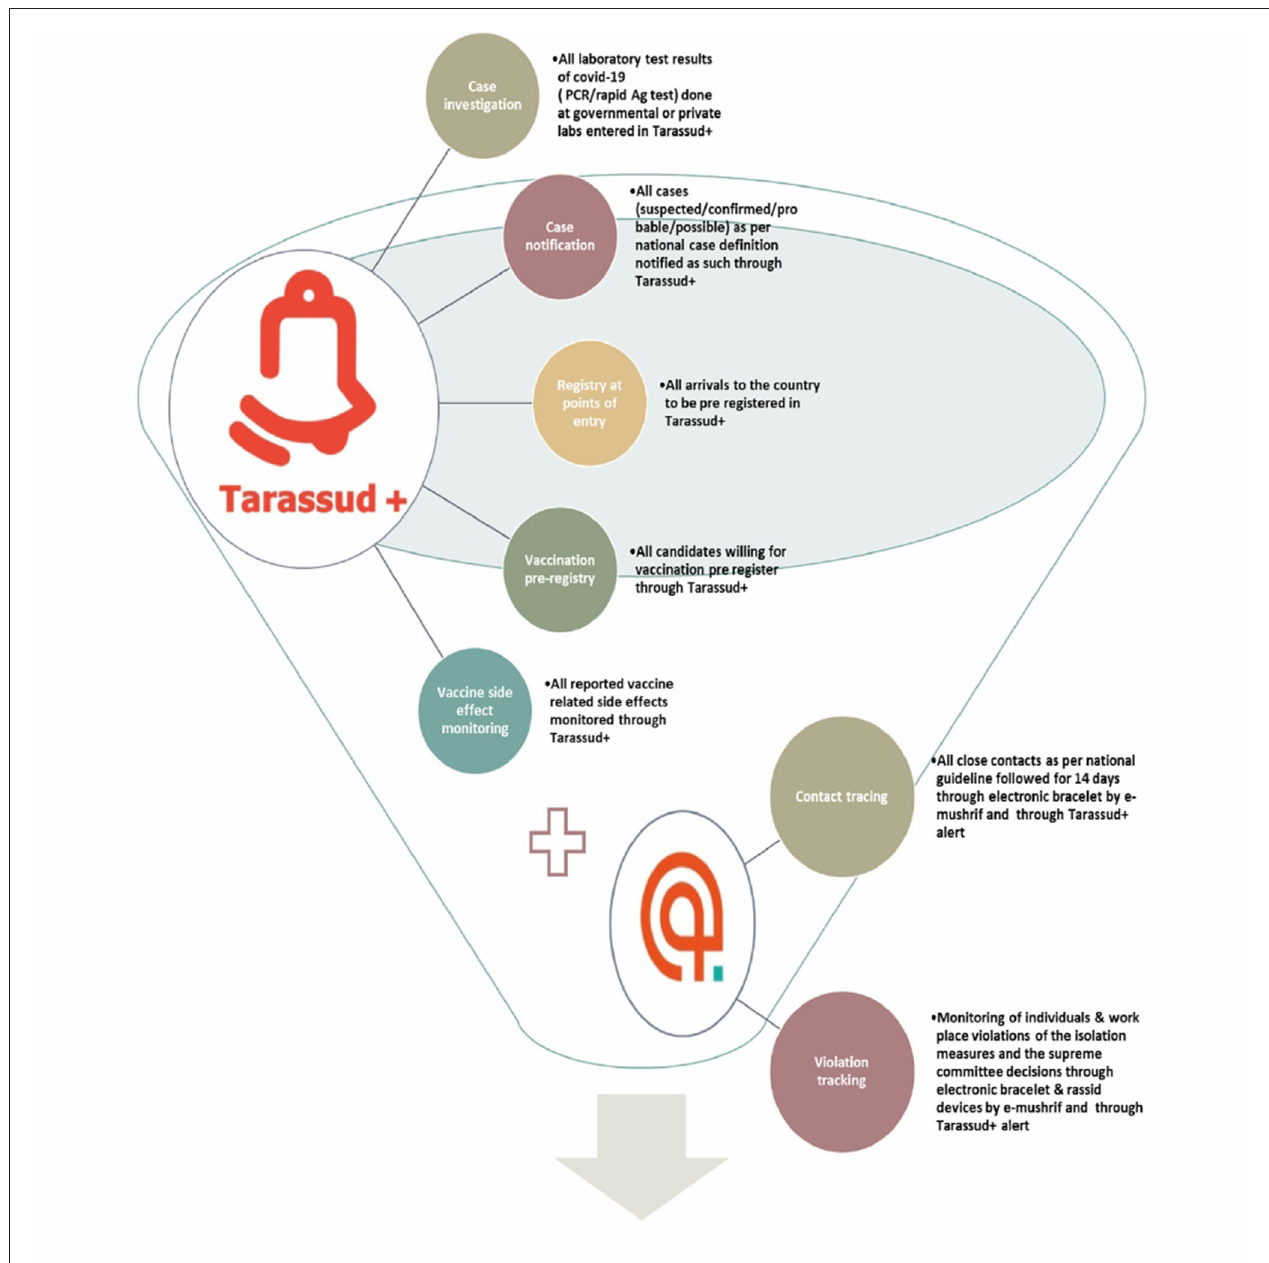
FIGURE 5 | Summary of the role of the Tarassud + and the e-mushrif during COVID-19 pandemic in